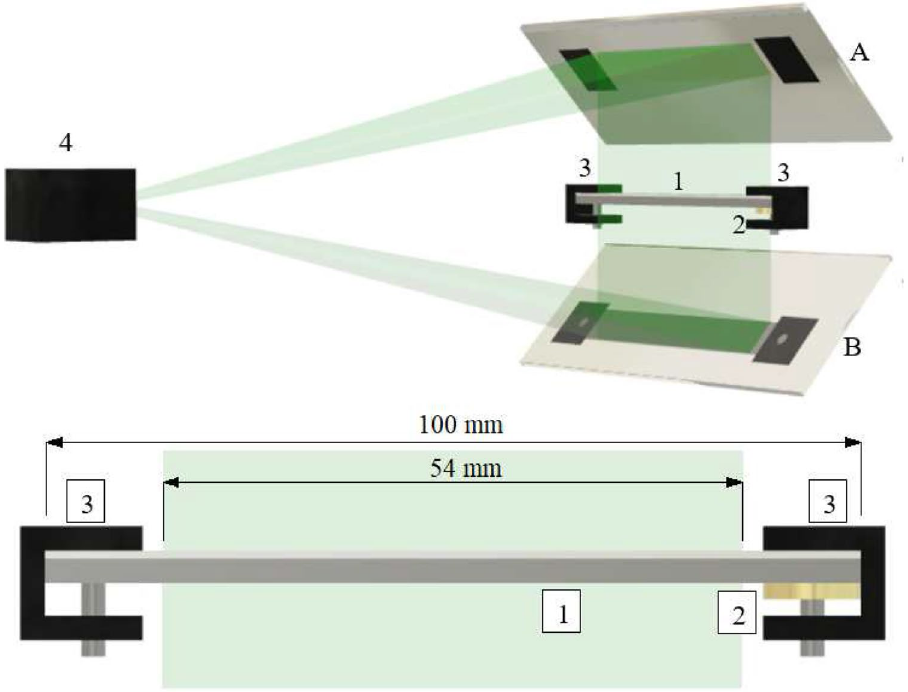
Figure 2. Experimental setup with the sample holder and the piezo transducer: 1: sample, 2: piezo transducer, 3: sample holders, 4: Vibromap, A: the mirror reflecting light from the upper surface of the sample, B: the mirror reflecting light from the lower surface of the sample reflected in the mirror 21